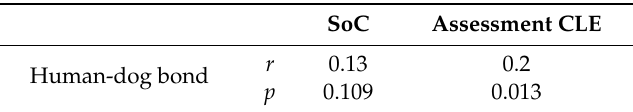
Table 4. Correlation between the human-dog bond and the strength of the sense of coherence, as well as between the human-dog bond and the assessment of critical life